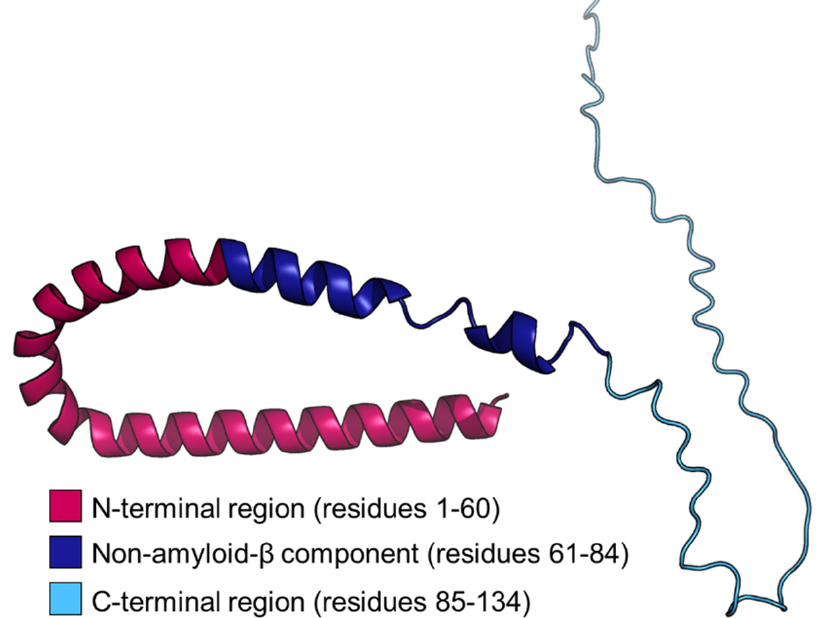
Figure 2. Predicted structure of β S. The sequence of human β S (UniProt accession code Q16143) was used to predict its full-length protein structure using AlphaFold [58] and visualized using Pymol. β S is arranged in a tripartite arrangement, with the N-terminal region (M1-K60, pink), central NAC region (E61-V84, dark blue), and the C-terminal region (K85-A134, light blue). The predicted N- terminal helical structure is reflective of the lipid-bound conformation of β S in this region. Model confidence was quantified with per-residue confidence scores (pLDDT) generated by AlphaFold, ranging from 0 to 100. Residues 1–30 and 32 were predicted with confidence with pLDDT scores of 70 to 90. Residues 31, 33–87, 91, 109, 113–114, 119–123, 125, and 127–133 were predicted with low confidence, i.e., with pLDDT scores of 50 to 70. Residues 88–90, 92–108, 110–112, 115–118, 124, 126, and 134 were predicted with very low confidence, i.e., with pLDDT scores below 50. Scores below 50 may suggest an unstructured region. No residues in human β S were predicted with very high confidence, i.e., with pLDDT scores above 90.